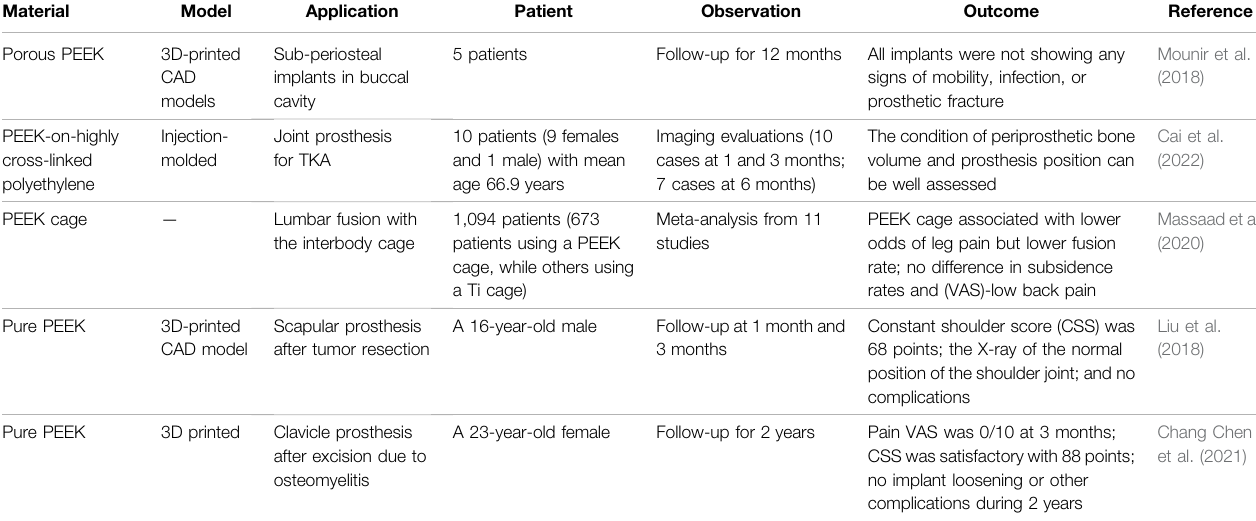
TABLE 1 | Clinical application of PEEK as